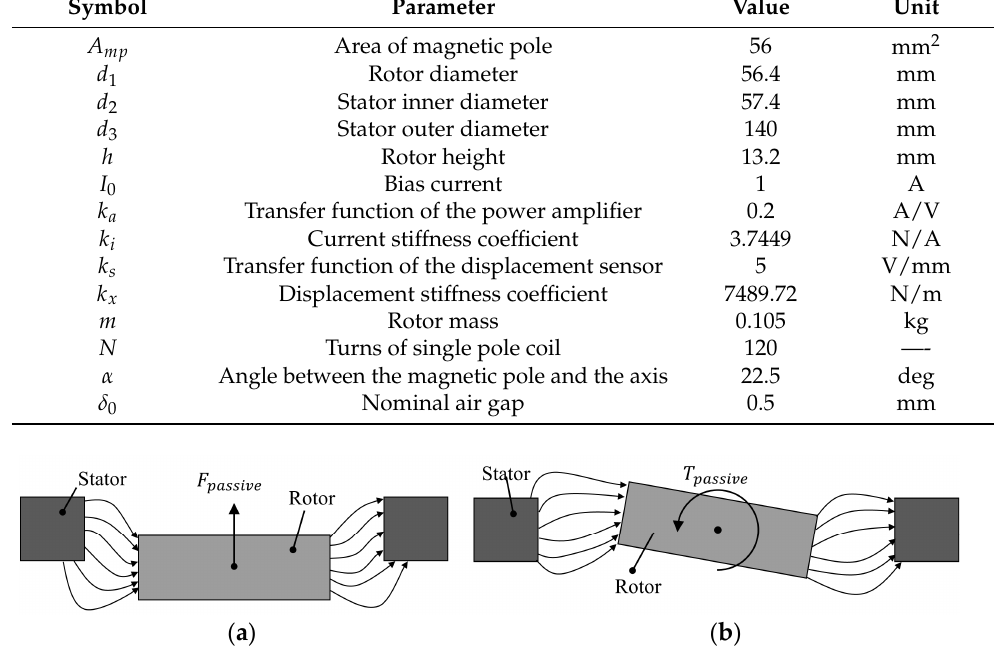
Figure 2. Passive stabilization: ( a ) Axial direction; ( b ) tilting directions.